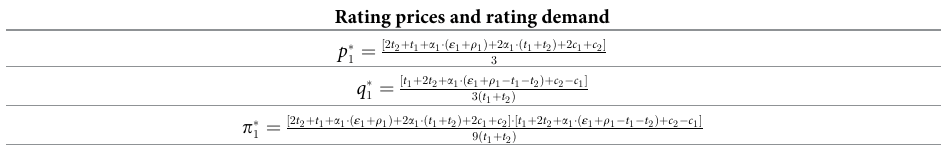
Table 1. Short-term equilibrium solutions of DRAs. Rating prices and rating